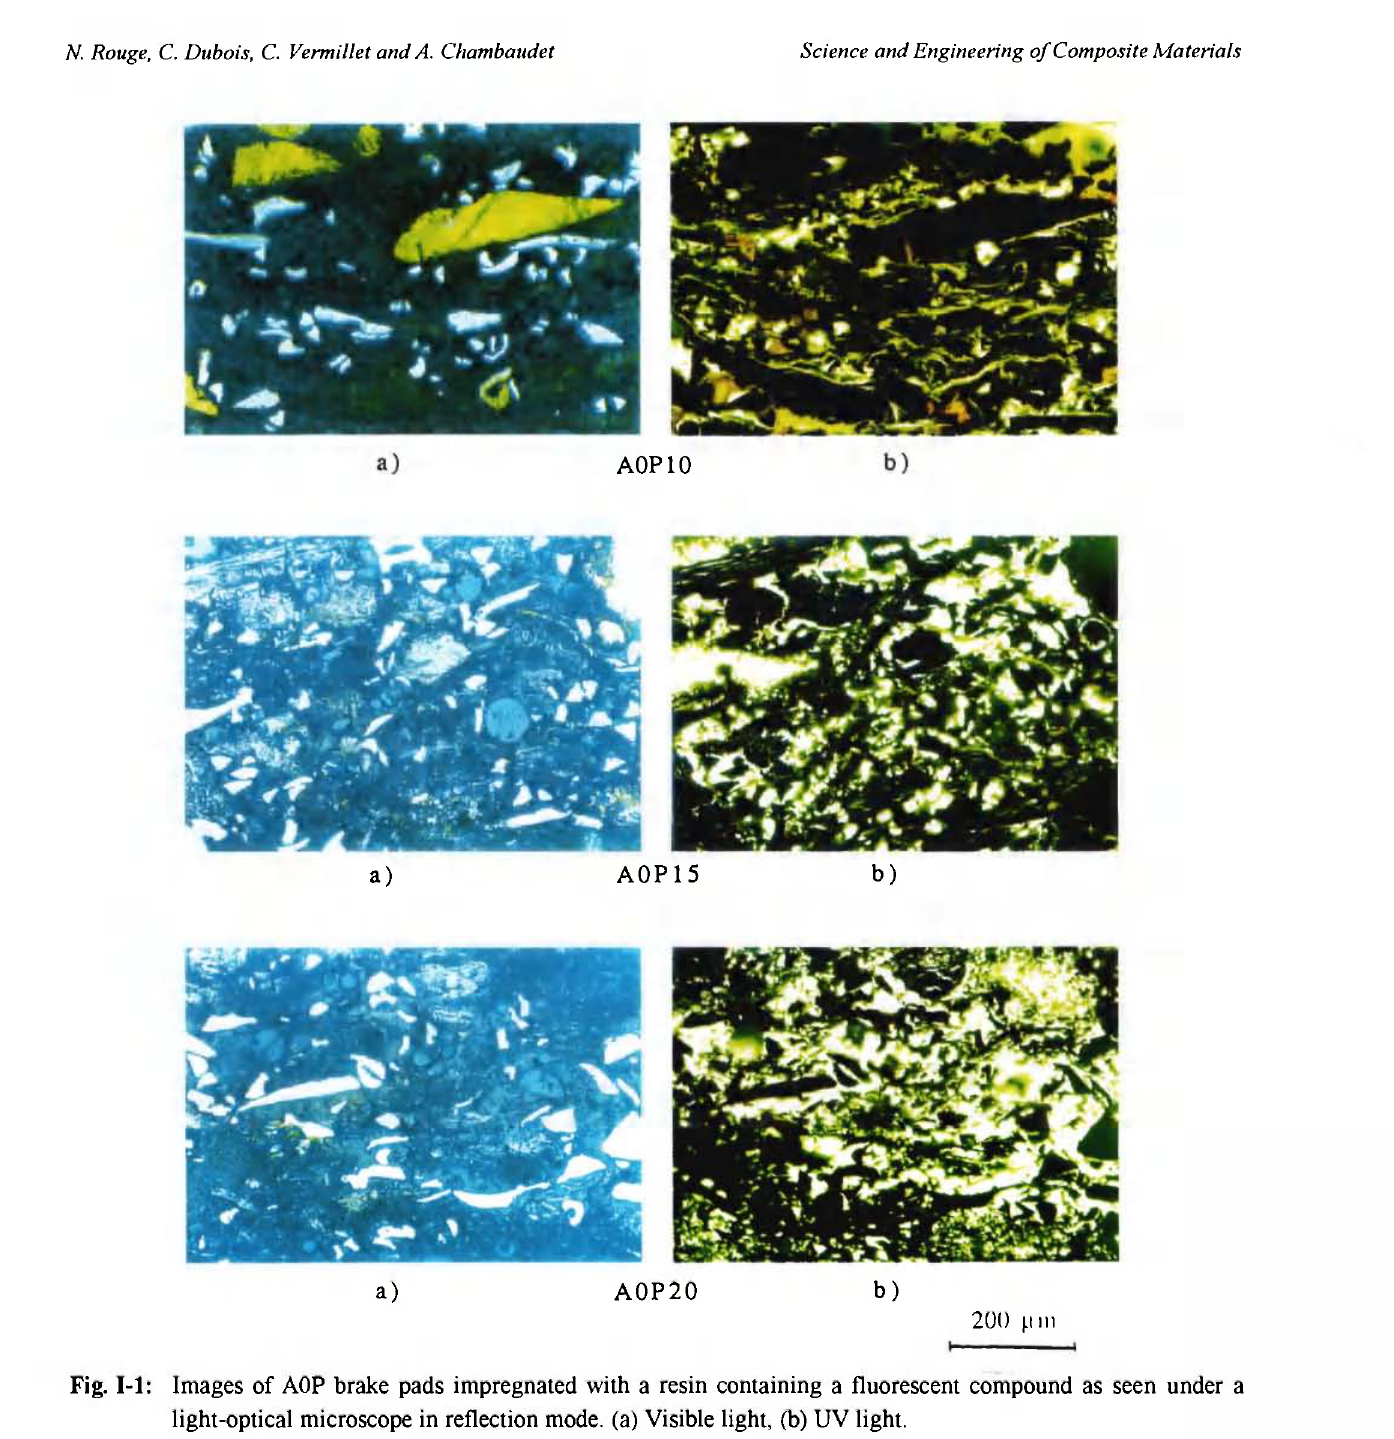
Fig. 1-1: Images of AOP brake pads impregnated with a resin containing a fluorescent compound as seen under a light-optical microscope in reflection mode, (a) Visible light, (b) UV